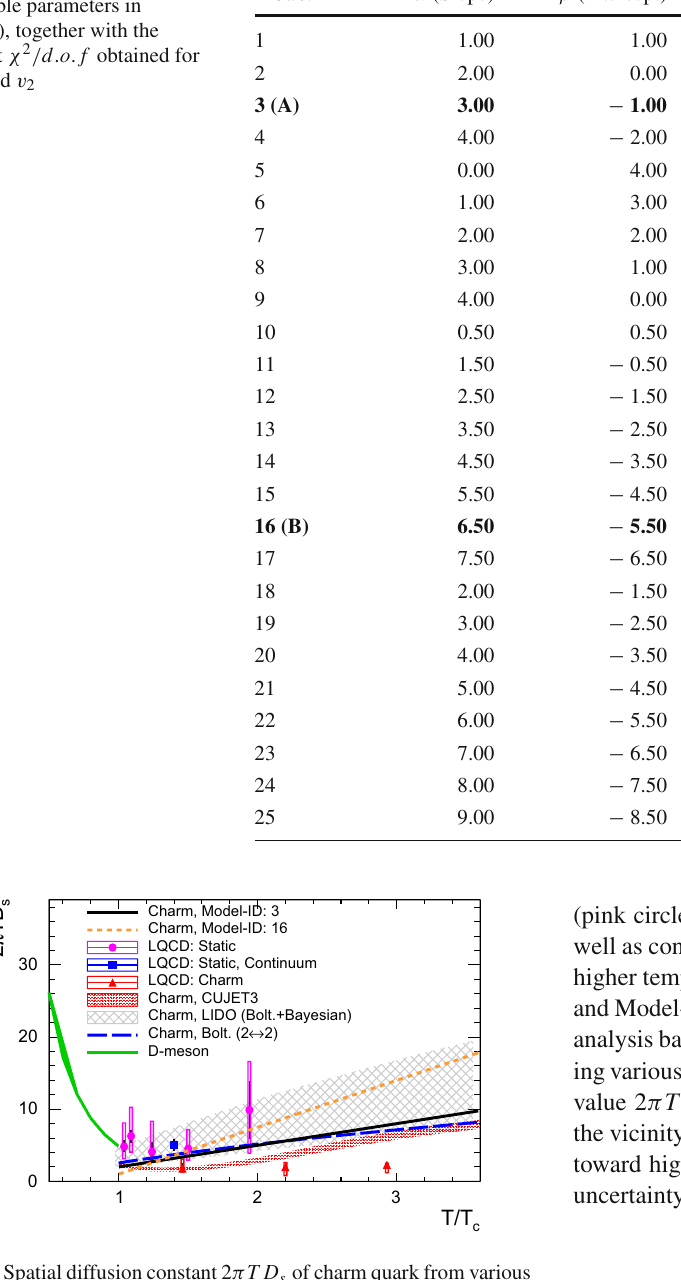
T c , the results from both LGR Model-A (solid black curve) and Model-B (dashed orange curve) are compatible with the LQCD calculations within their significant uncertainties